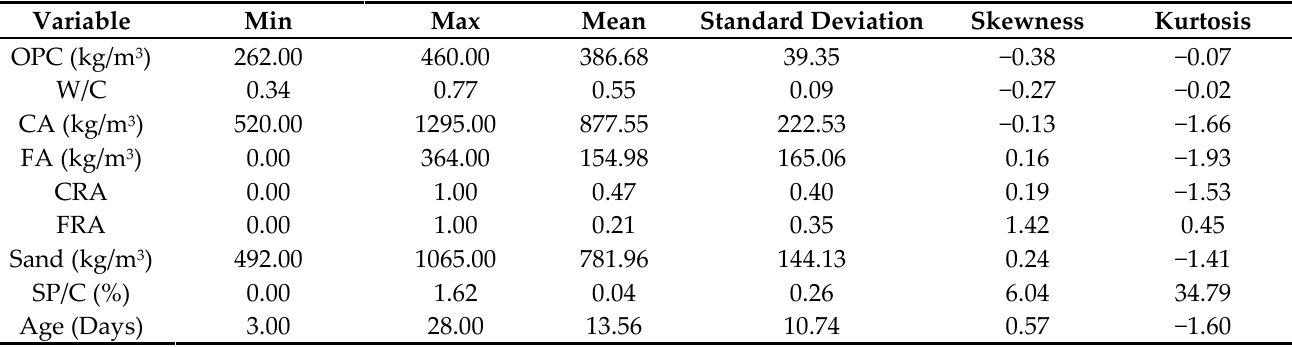
Table 1. Anatomical statistics of the inputs and